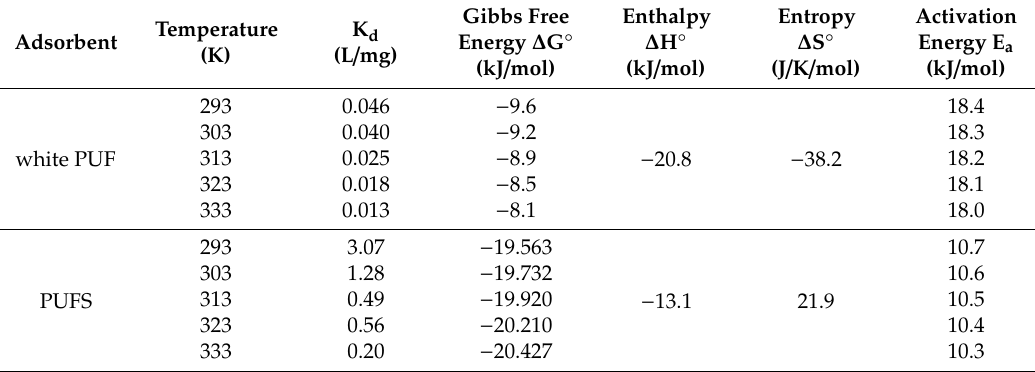
Table 4. Thermodynamics of the Sorption of Chlorpyrifos onto White-PUF and